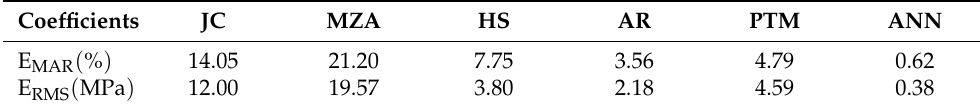
Table 7. Accuracy coefficients for all the analyzed